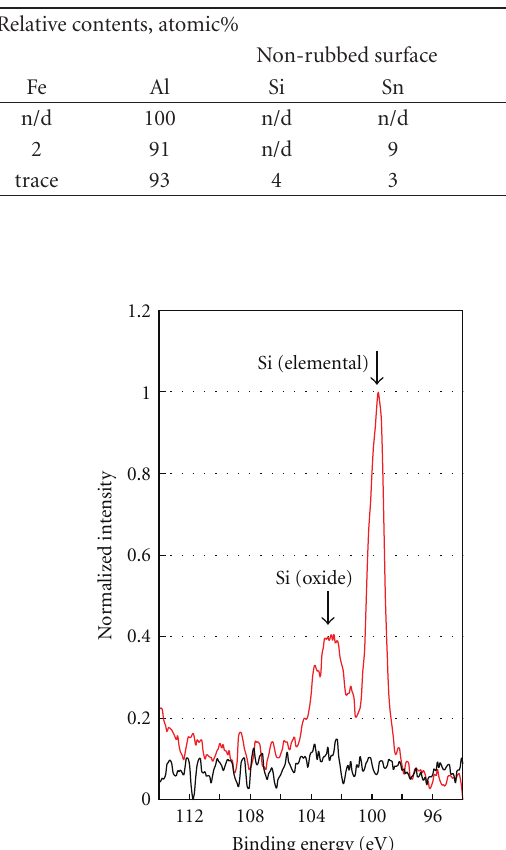
Table 4: Contents of element on surface.